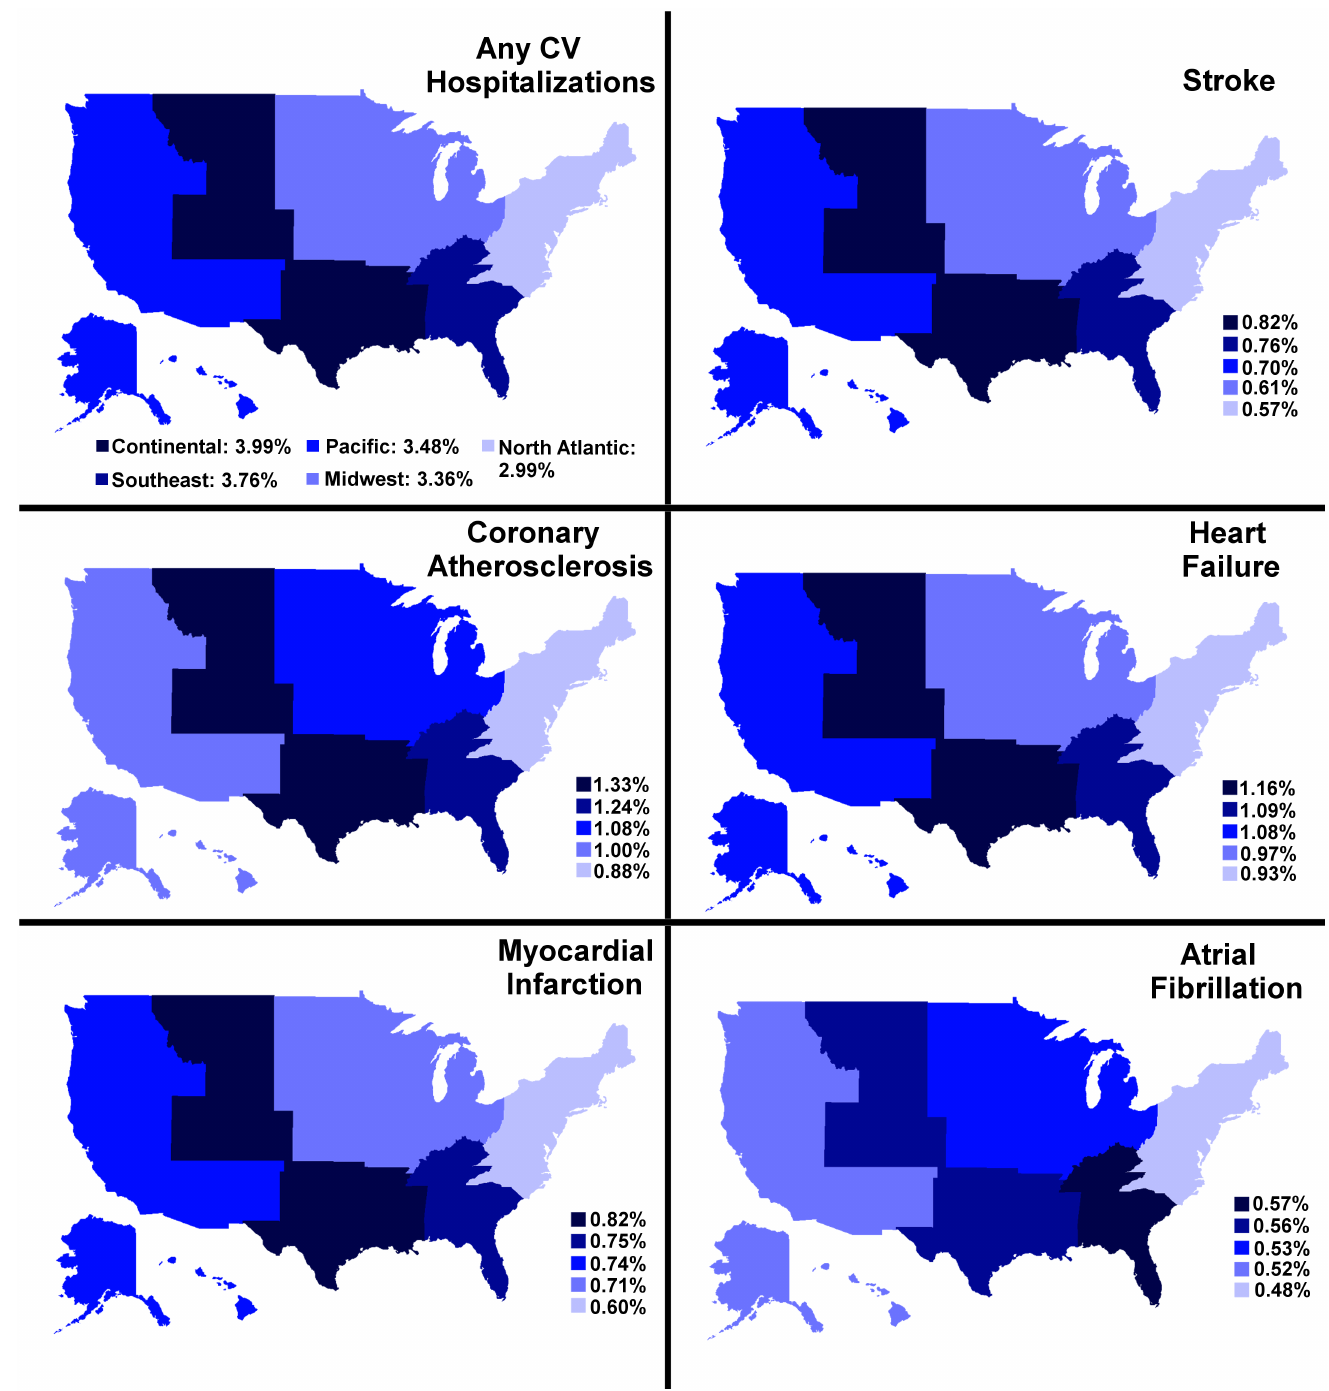
Fig 3. Variation in hospitalization rates by region. [Figure similar but not identical to the original image obtained from USGS National Map Viewer (open access) at http://viewer.nationalmap.gov/viewer/, and is therefore for illustrative purposes only].